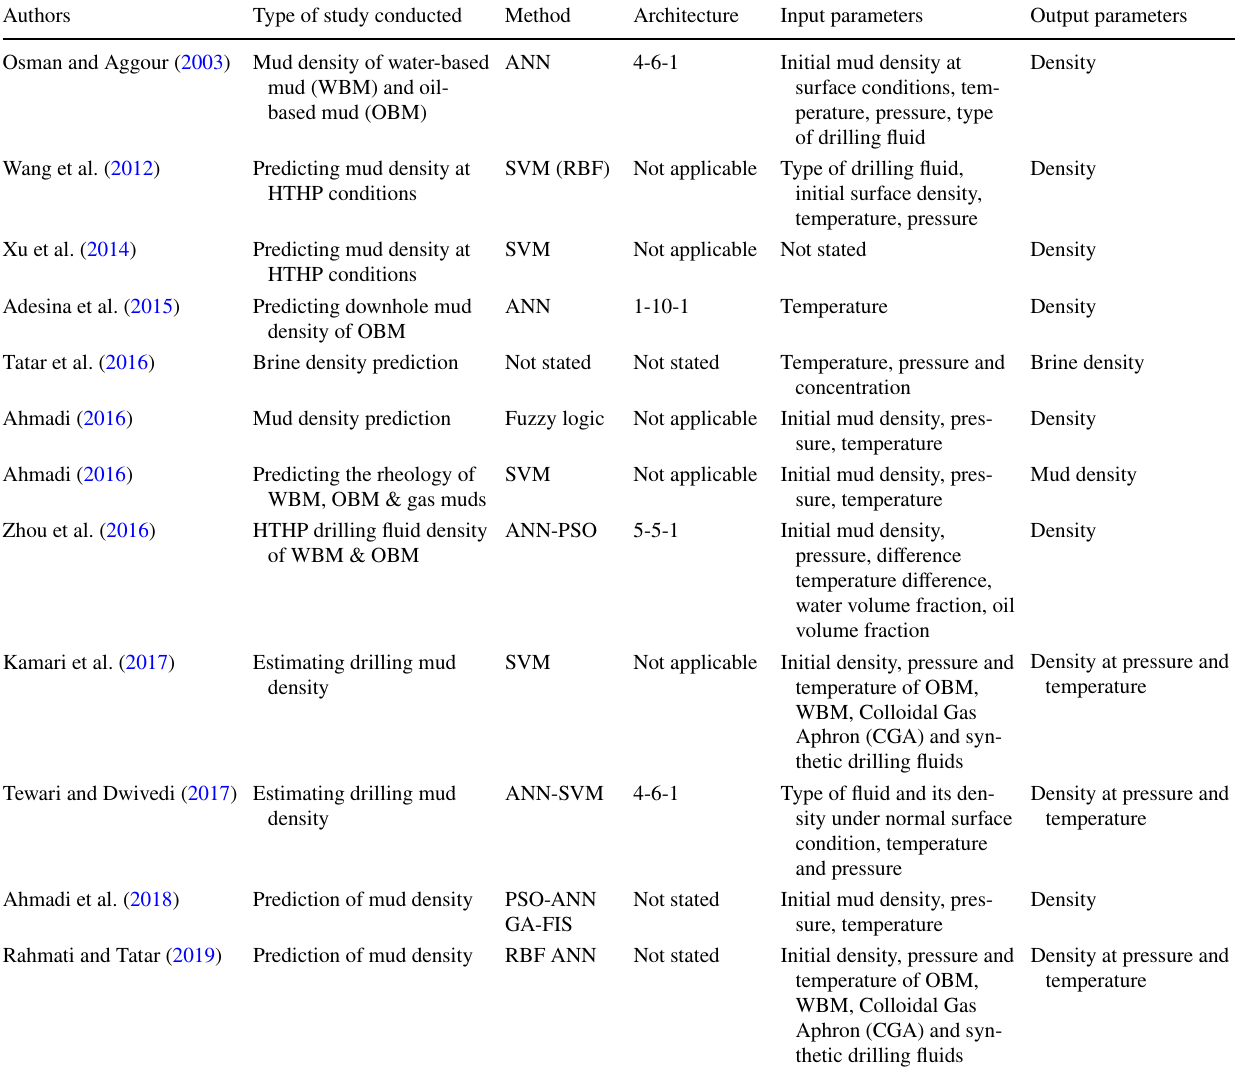
Table 2 Summary of researches on mud density prediction using artificial intelligence Authors